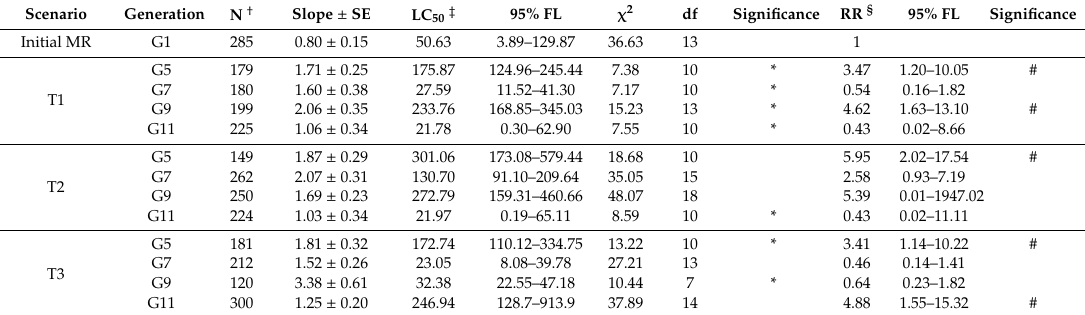
Table 4. Susceptibility to lambda-cyhalothrin in the multi-resistant strain MR of Ceratitis capitata under three di ff erent scenarios of insecticide treatments, T1: alternation of spinosad for three generations and lambda-cyhalothrin for one generation; T2: alternation of spinosad for two generations and lambda-cyhalothrin for two generations; T3: non-treated. See Figure 1 for more details. Scenario